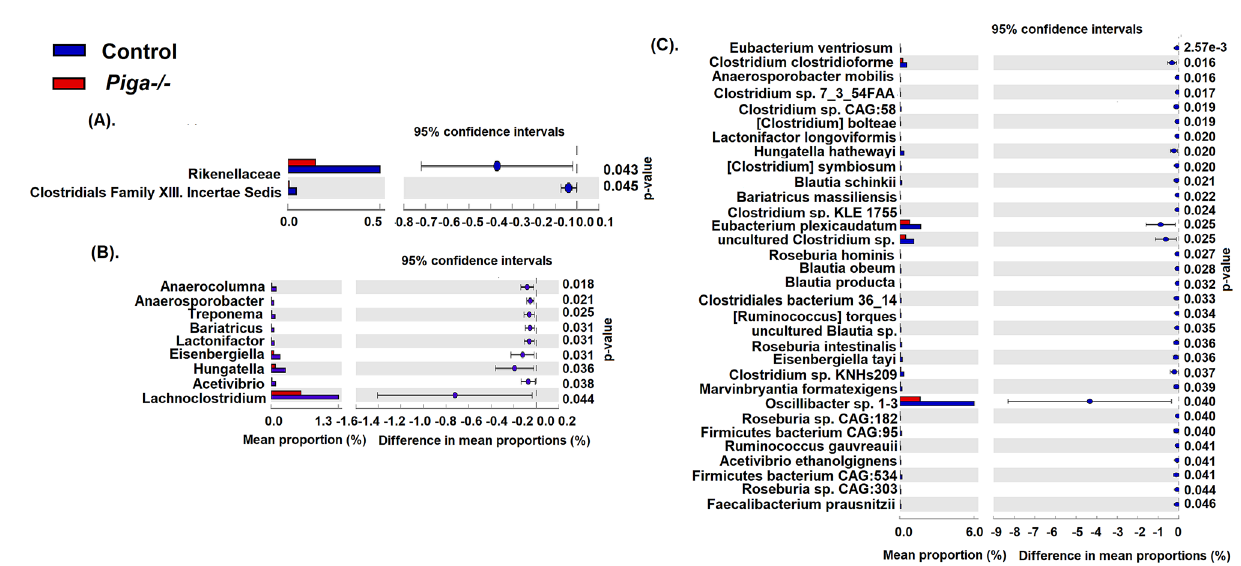
Figure 2. Extended bar chart represents statistically differing taxa at ( A ) family, ( B ) genus, and ( C ) species levels. Welch’s t-test was performed with p < 0.05 and a confidence interval of